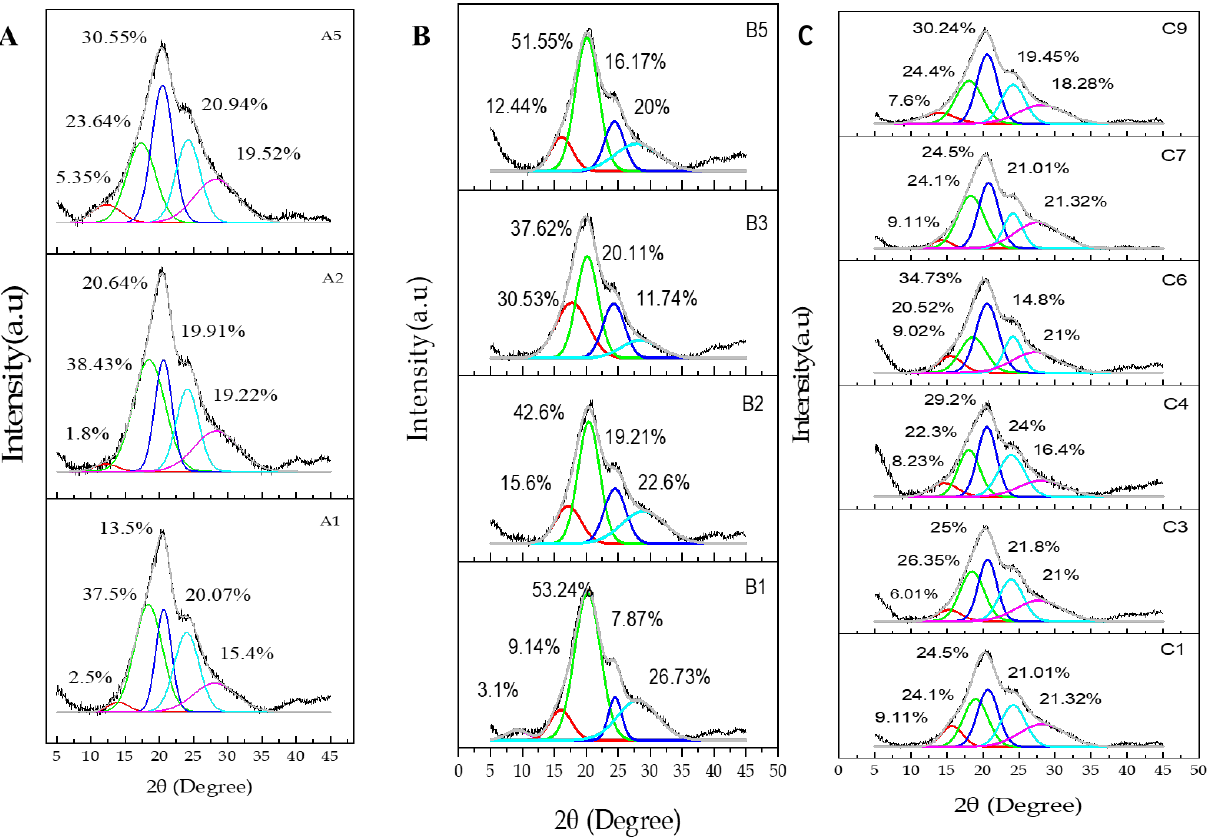
Figure 8. X-ray patterns of ( A ) SF/HA hydrogels; ( B ) curcumin-loaded SF; and ( C ) curcumin-loaded SF/HA hydrogels.